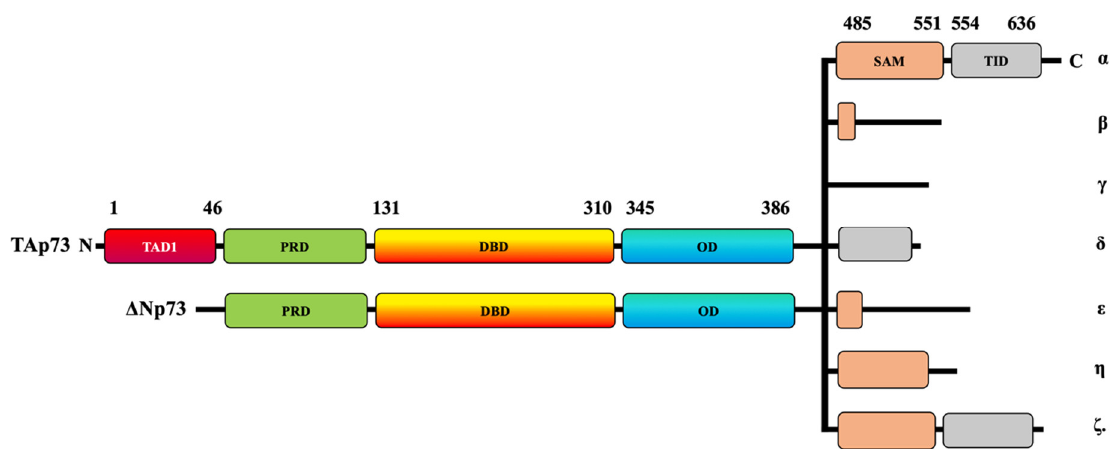
Figure 1. Schematic representation of TAp73 and ∆ Np73 domains. The human p73 protein comprises transcriptional activating domains (TADs) and a proline-rich domain (PRD) at its N - terminal and a DNA-binding domain (DBD). The p73 C - terminal domain is composed of an oligomerization domain (OD), a sterile alpha motif (SAM) domain, and a transactivation inhibitory domain (TID). At least two N - terminal isoforms, TAp73 and ΔNp73, can be combined with the C - terminal α, β, γ, δ, ε, ζ, and η isoforms.